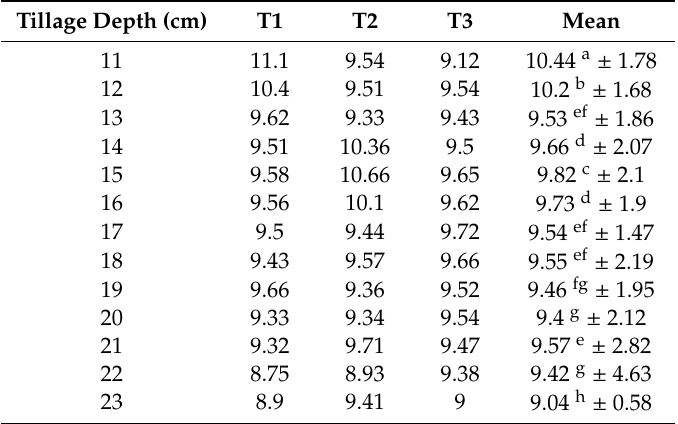
Figure 11. Overall mean fuel consumption according to tillage depth: ( a ) fuel consumption rate, and ( b ) specific fuel consumption. Table 7. Descriptive statistics of fuel consumption rate (kg / h) according to tillage